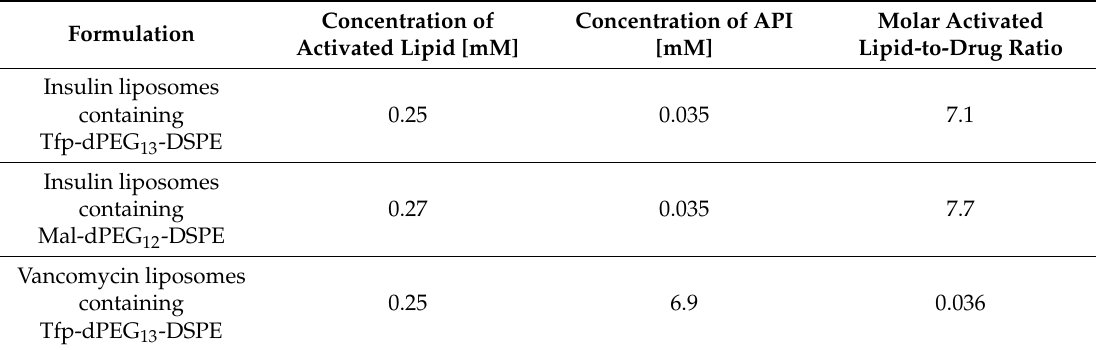
Table 2. Comparison of lipid-to-drug ratio of the di ff erent liposomal formulations. Concentration Formulation